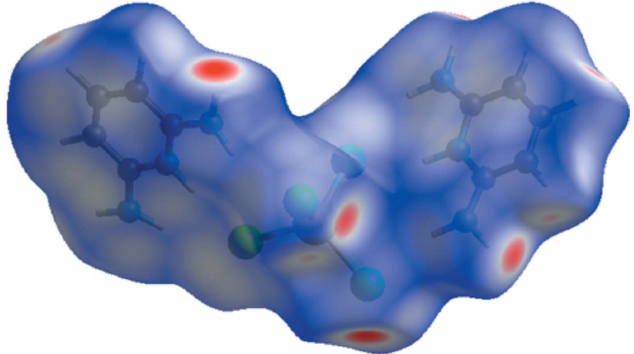
(4), R 2 (6), R 1 (6), R 4 (8) and R 2 (8). 2 2 2 4 2